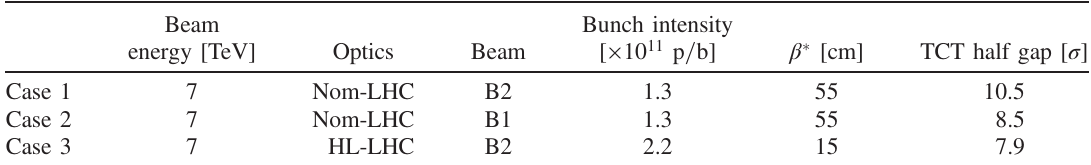
TABLE III. Summary of scenarios selected for simulation